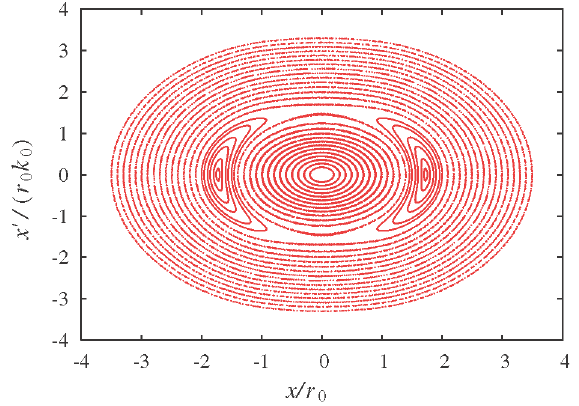
FIG. 2. (Color) Stroboscopic plot for (cid:16) (cid:3) 0 : 95 , 0 : 2 (cid:11) (cid:11) 3 : 5 , and (cid:18) (cid:3) 0 : 8 . x (cid:4) 0 (cid:5) =r 0